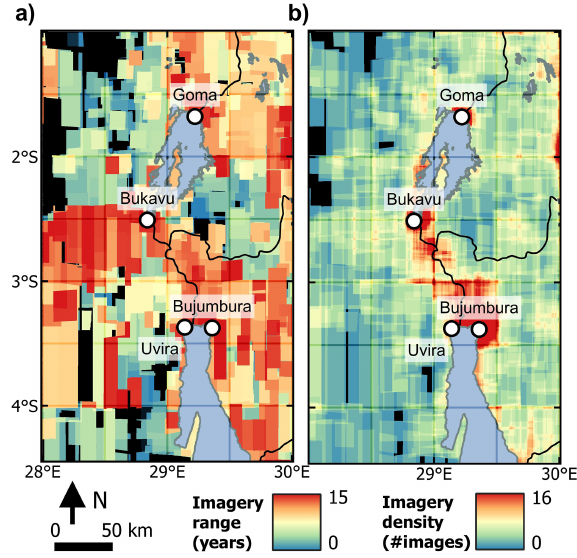
Figure 5. Visualization of the imagery bias in © Google Earth prior to 4 May 2019: (a) imagery range and (b) imagery density. The range and density were calculated by manually identifying 932 im- agery footprints. The highest imagery density is available for the major cities in the study area (Goma, Bukavu, and Bujumbura), whereas the northwest and southwest regions have fewer observa- tions. For some areas (in black) there is no available